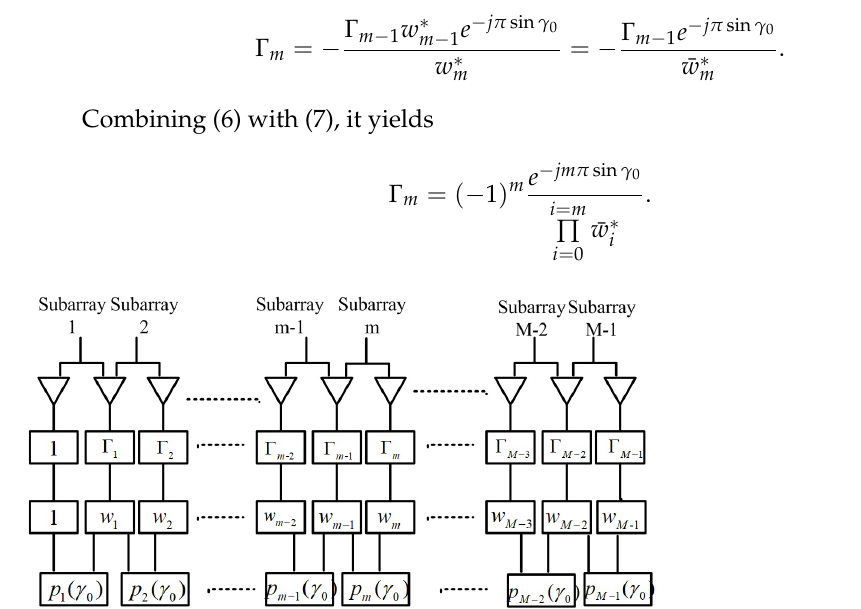
Figure 2. The diagram of the proposed method.